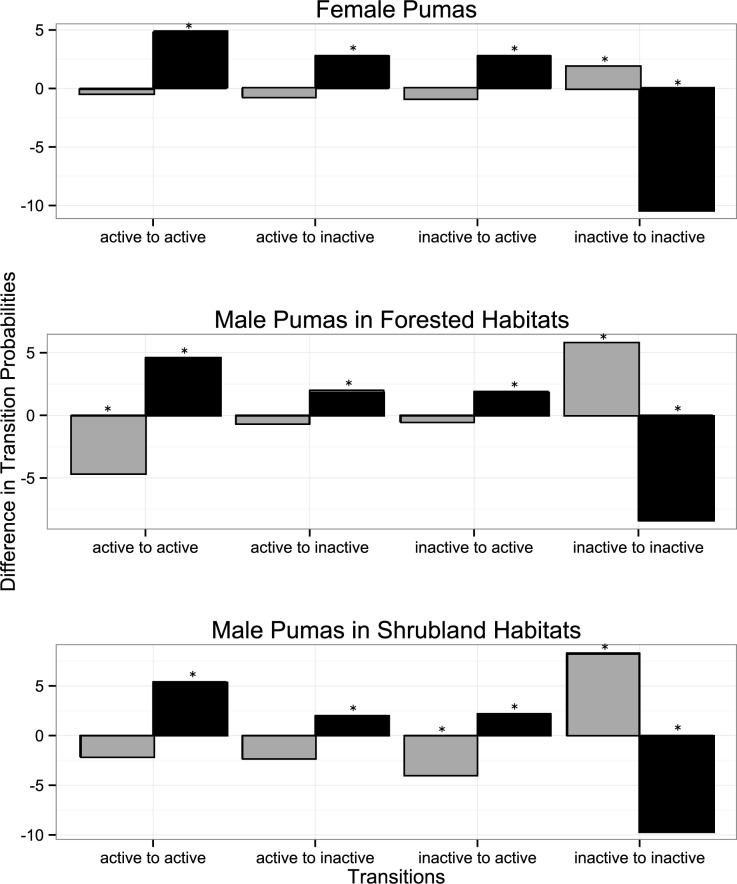
The effect of proximity to houses on the daytime (gray) and nighttime (black) transition probabilities between activity states for female pumas, male pumas in forested areas, and male pumas in shrubland habitats.Difference in transition probabilities is calculated as probability of transitioning between states when pumas are ≤150m from buildings subtracted by the probabillity of transitioning between states when pumas are >150m from buildings. A positive value means pumas are more likely to engage in those transitions when close to buildings than when further away. Asterisks above columns represent significant differences between transition probabilities close and far from houses (P < 0.05).